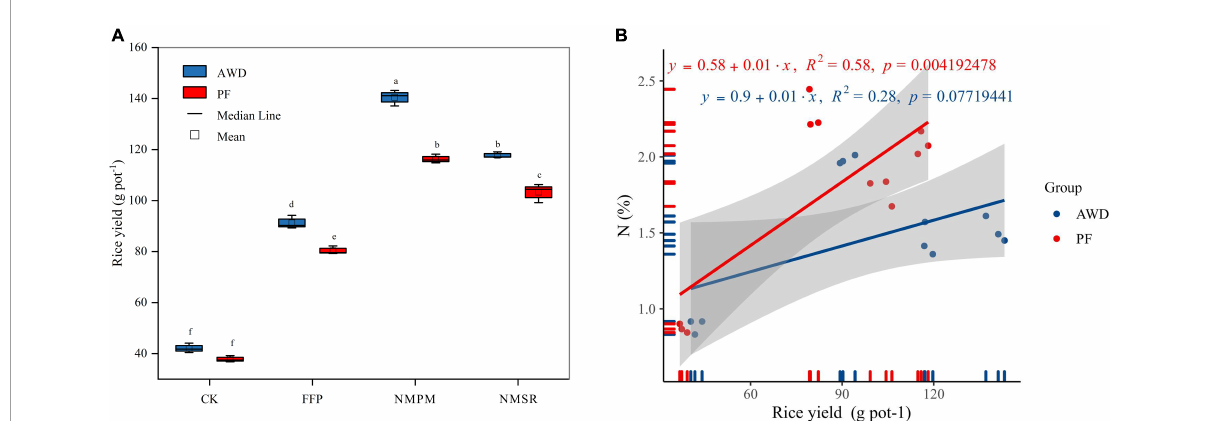
FIGURE3 Combined effects of different fertilizer treatments on (A) rice yield (g pot − 1 ) during alternate wetting and drying (AWD) and permanent flooding (PF). The arrow bar above the line shows standard error. The different letters show significant difference, while the same letters represent no significant differences among the treatments. (B) Correlation between rice yield and nitrogen concentration during AWD and PF water